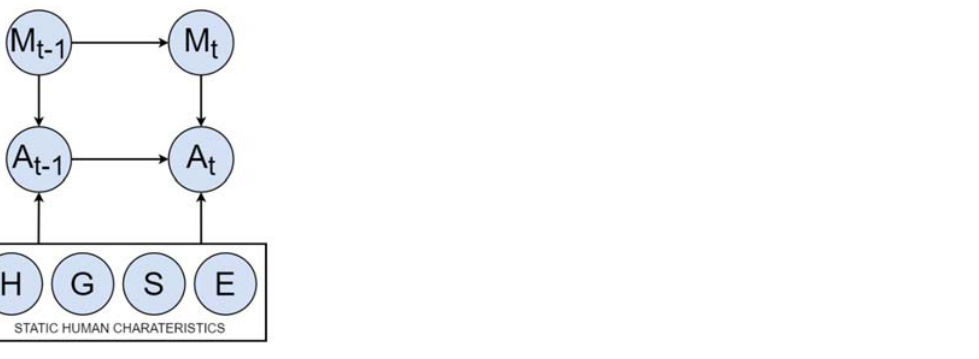
Figure 4. The proposed DBN architecture with the evolution of the mood and the assembly state of the tablet.